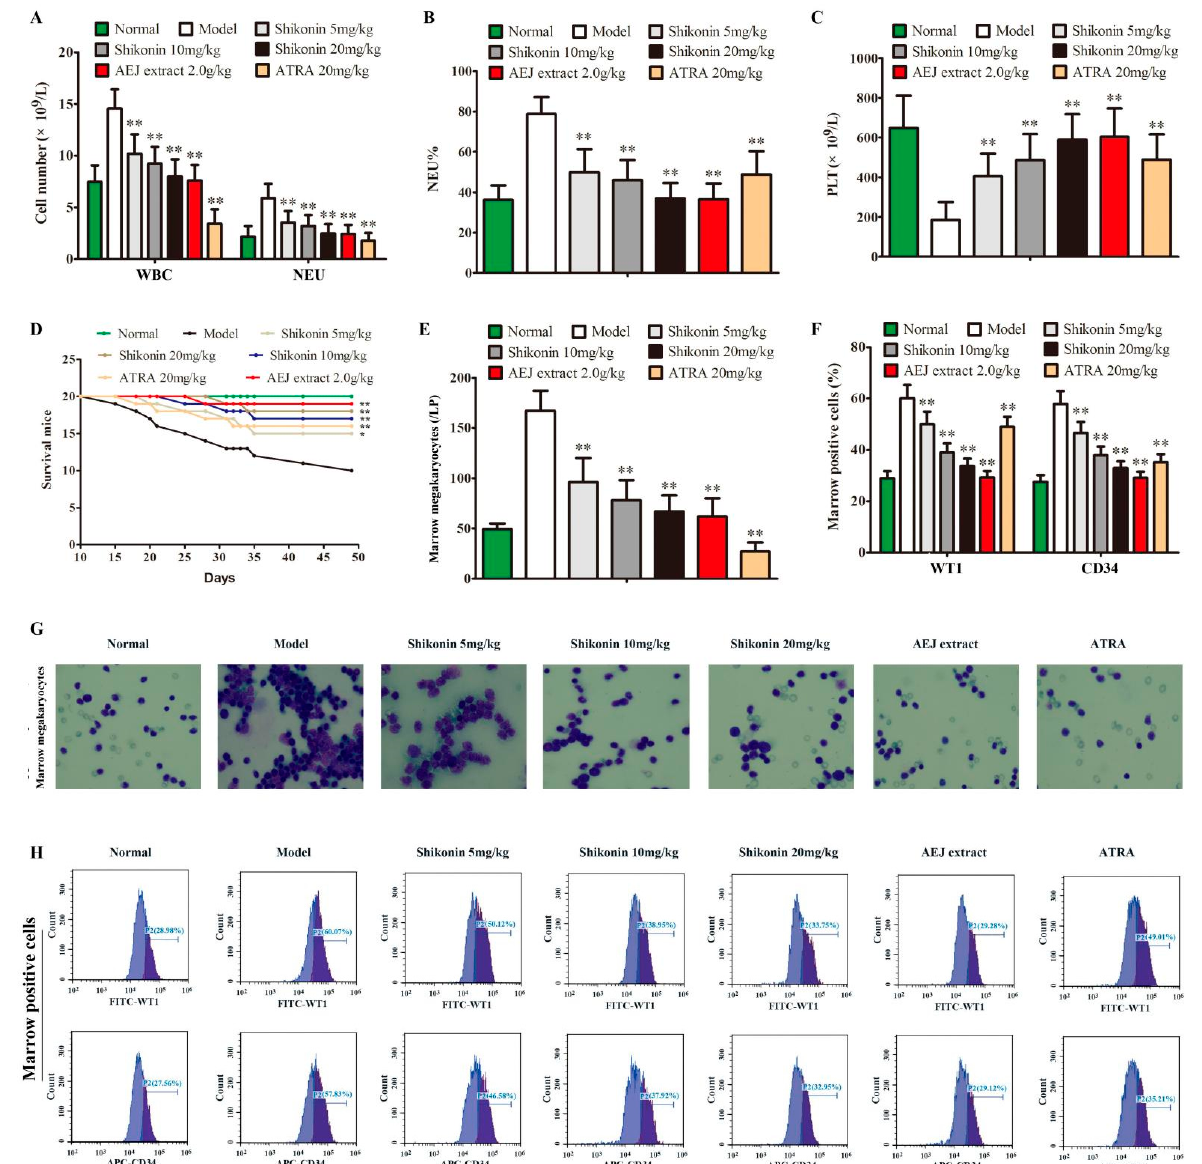
Figure 7. Shikonin has anti-leukemia activity in vivo. Leukemia mice were treated for 7 weeks, and the blood routine was examined. ( A ) White blood cells (WBCs) and neutrophils (NEUTs) (n = 10). ( B ) Percentage of neutrophils (NEU%) (n = 10). ( C ) Platelet (PLT) detected. ( D ) Mouse survival curve (n = 20). ( E , G ) Marrow megakaryocytes in marrow smears indicated by wright Giemsa staining (n = 5). ( F , H ) WT1- and CD34-positive cells in marrow cells detected by flow cytometry (n = 5). The data were presented as mean ± SD. * p < 0.05; ** p < 0.01 compared to the untreated model.